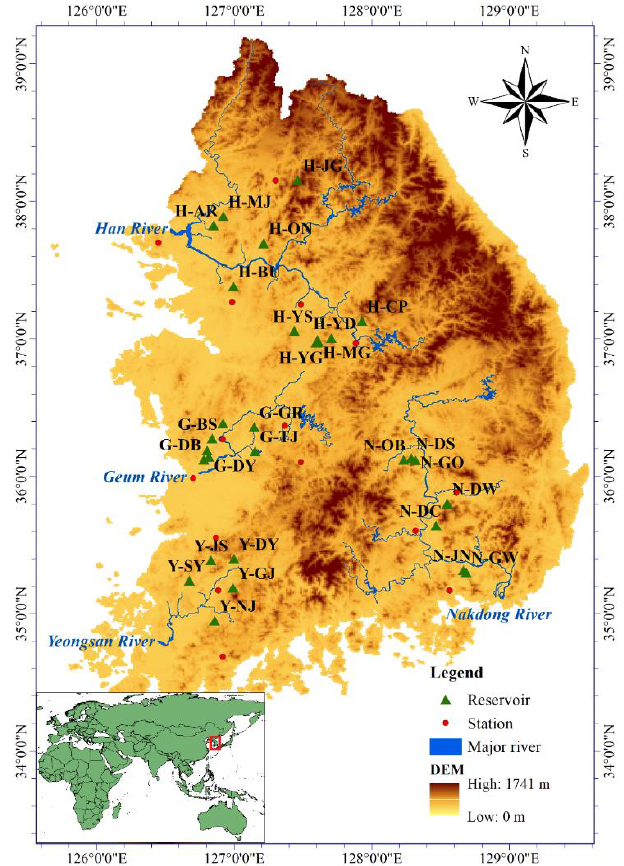
Figure 2. Location of weather stations, 30 agricultural reservoirs, and four major rivers in South Korea. The red circle means a weather station, and the green triangle means an agricultural reservoir. Four major rivers are shown on the digital elevation model (DEM). Refer to Table 1 for reservoir names.